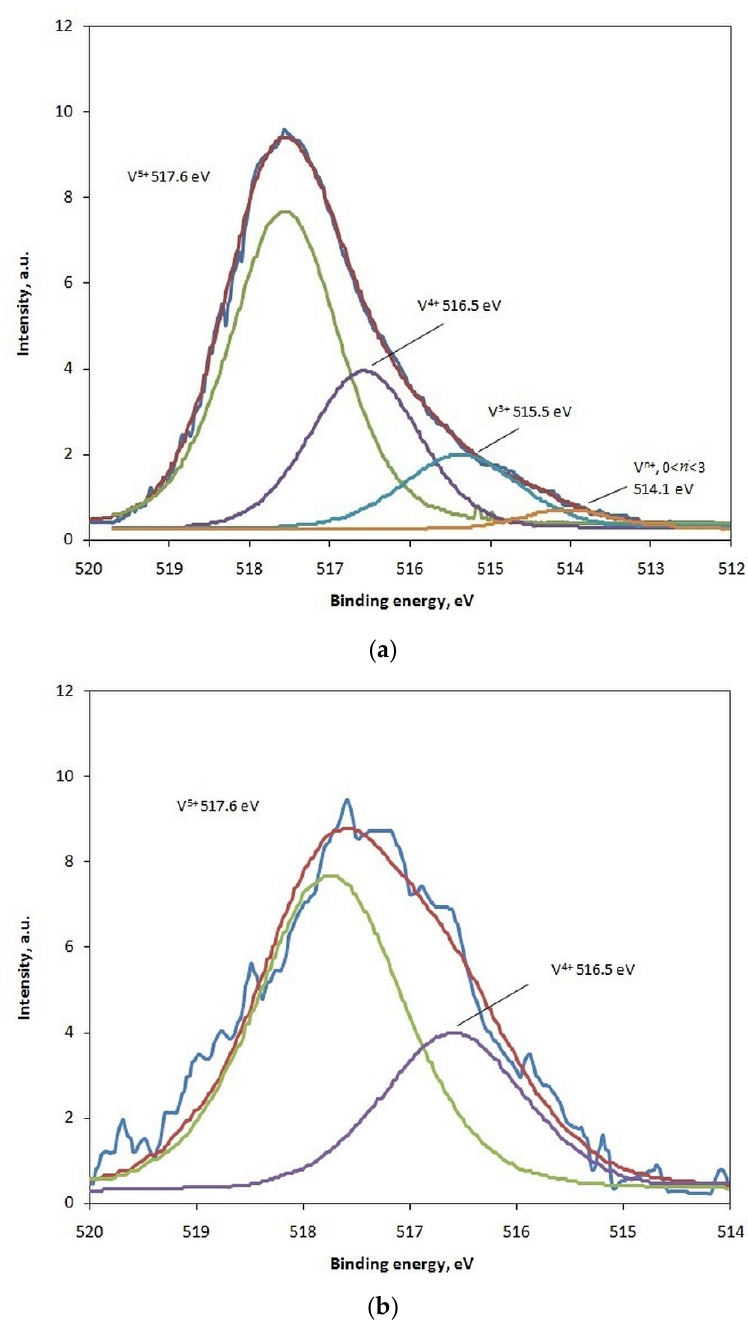
Figure 4. XPS V2p spectra from the surface of slag no. 3 ( a ) and ash ( b ) samples. Table 7. Content of vanadium with different oxidation degrees in ash and slag samples.